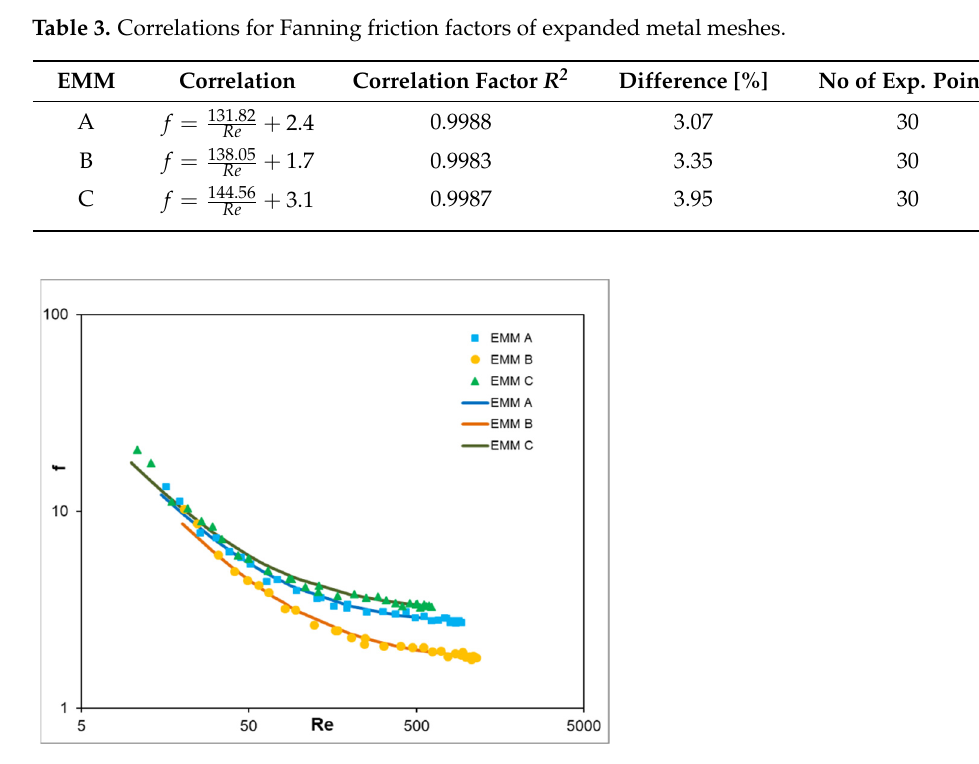
Figure 5. Flow resistance characteristics derived from experiments (points) and modeling (lines): ( left )—unit pressure drop vs. superficial gas velocity; ( right )—Fanning friction factor vs. Reynolds number.